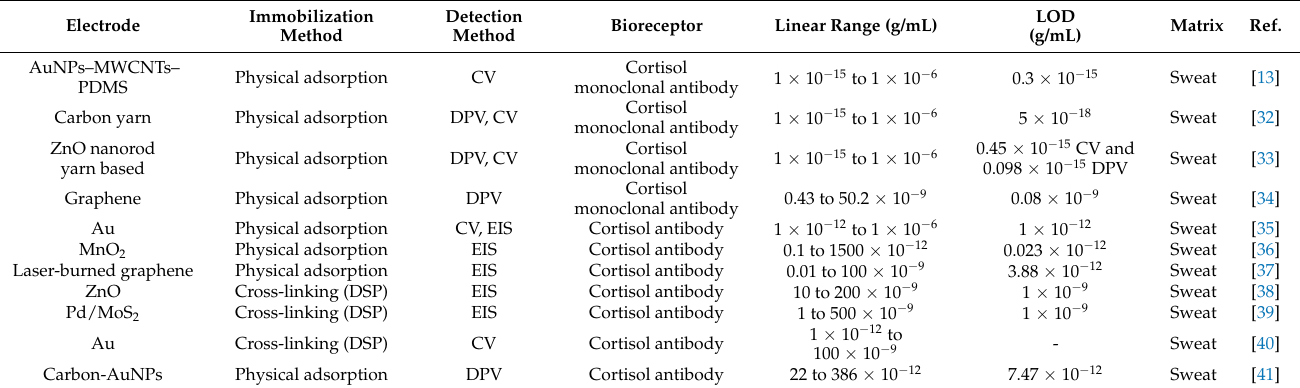
Table 1. Summary of electrochemical immunosensors functioning via cortisol antibody